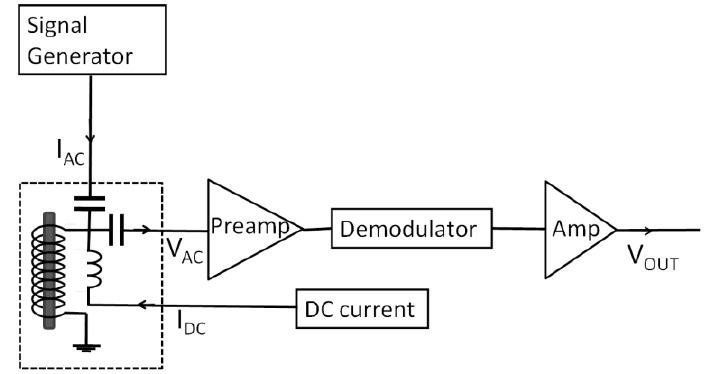
Figure 2. Block diagram of the driving circuit of the magnetic